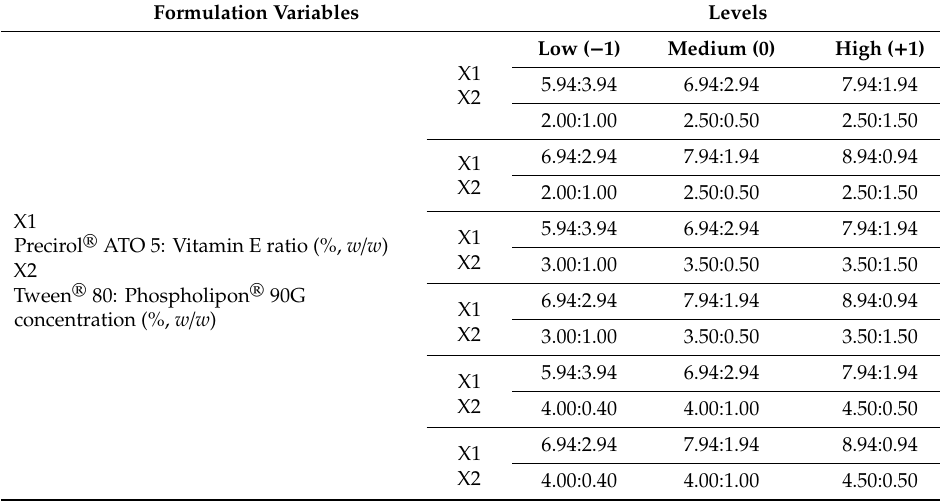
Table 1. Design of experiment (DoE) using six central composite design (CCD) for rivastigmine-loaded nanostructured lipid carriers (NLC) formulations with di ff erent critical material attributes (CMAs). Formulation Variables Levels